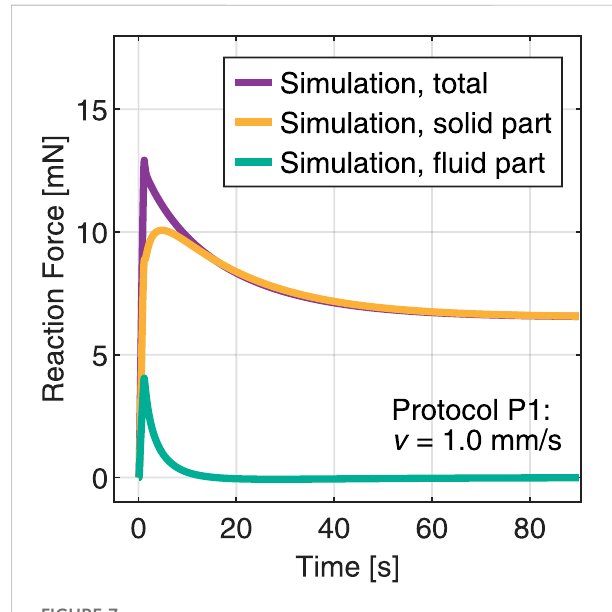
FIGURE 7 Simulation of an indentation test with protocol P1 and splitting the total reaction force into fl uid and solid